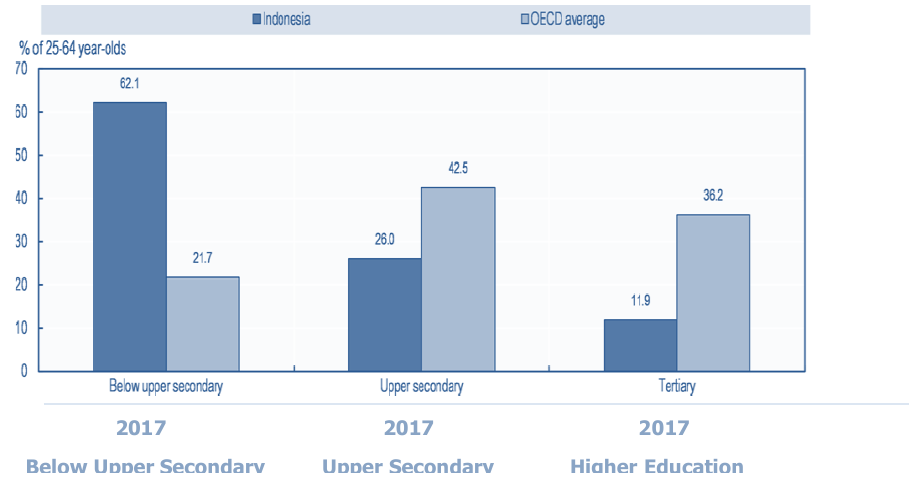
Figure 5: The Majority of the Indonesian Population attains below Upper Secondary Education ; Source: The indicators of educational attainment of the workforce in Indonesia in percentage retrieved from OECD 2020